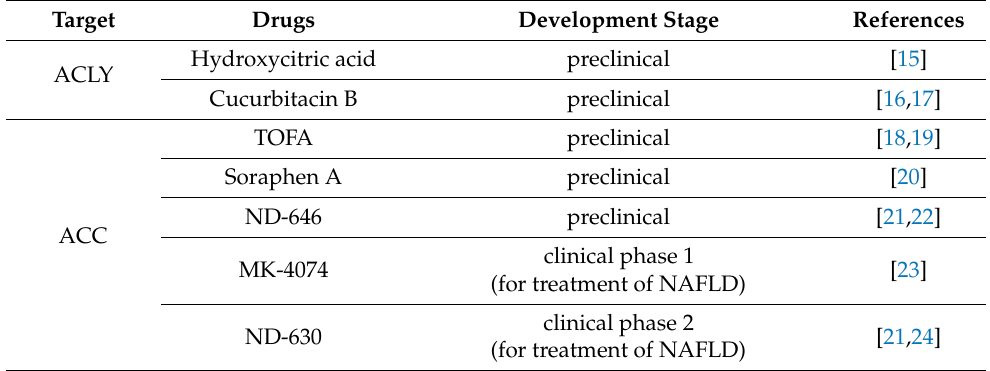
Table 1. Drugs targeting de novo FA synthesis pathway for cancer